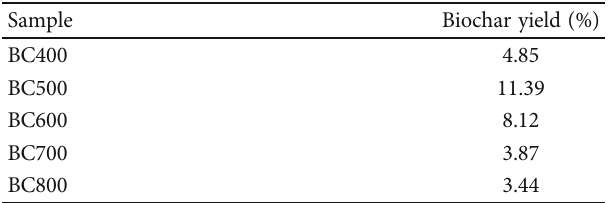
Table 1: Yield of biochar at di ff erent pyrolysis